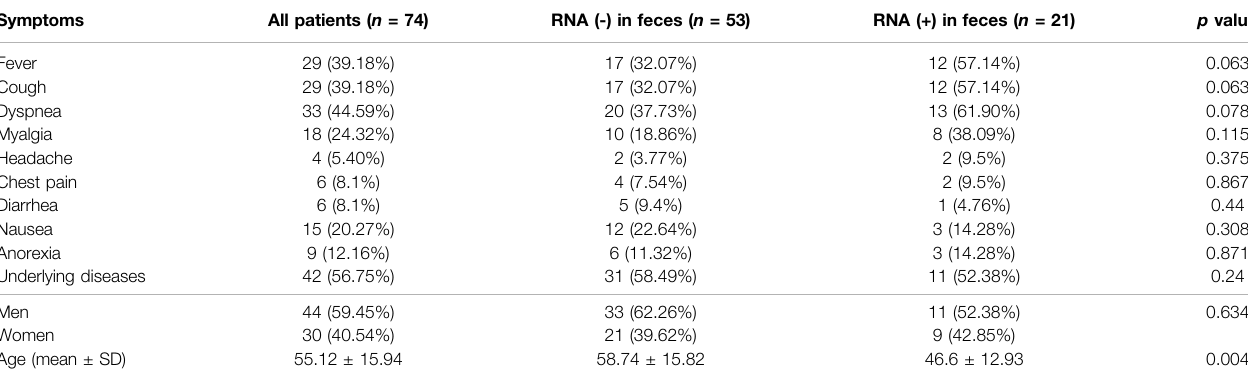
TABLE 3 | A comparison of demographic and clinical data of patients with SARS-CoV-2 RNA positive/negative results in stool samples. Symptoms All patients ( n = 74) RNA (-) in feces ( n = 53) RNA (+) in feces ( n = 21) p value